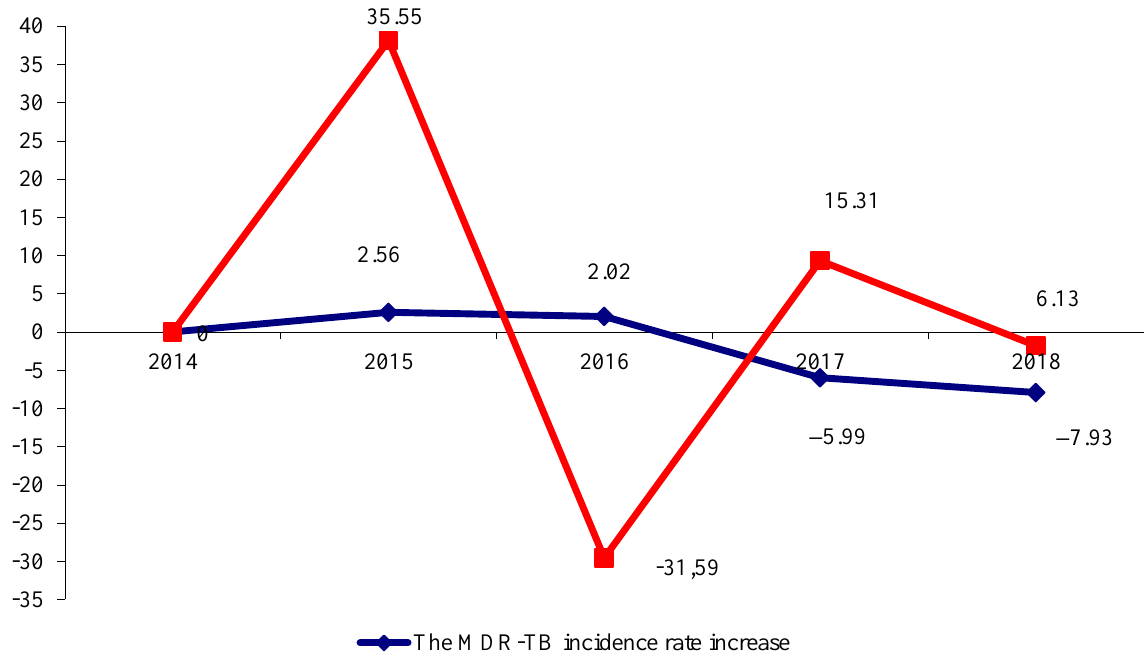
Fig. 2. The dynamics of the growth rate of the number of registered MDR-TB cases and the purchase of anti-TB D